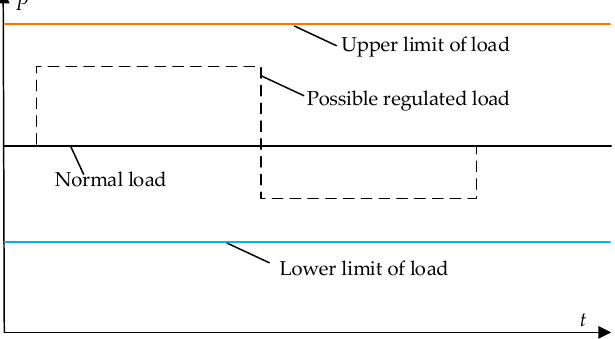
Figure 1. Regulation characteristics of electrolytic aluminum.